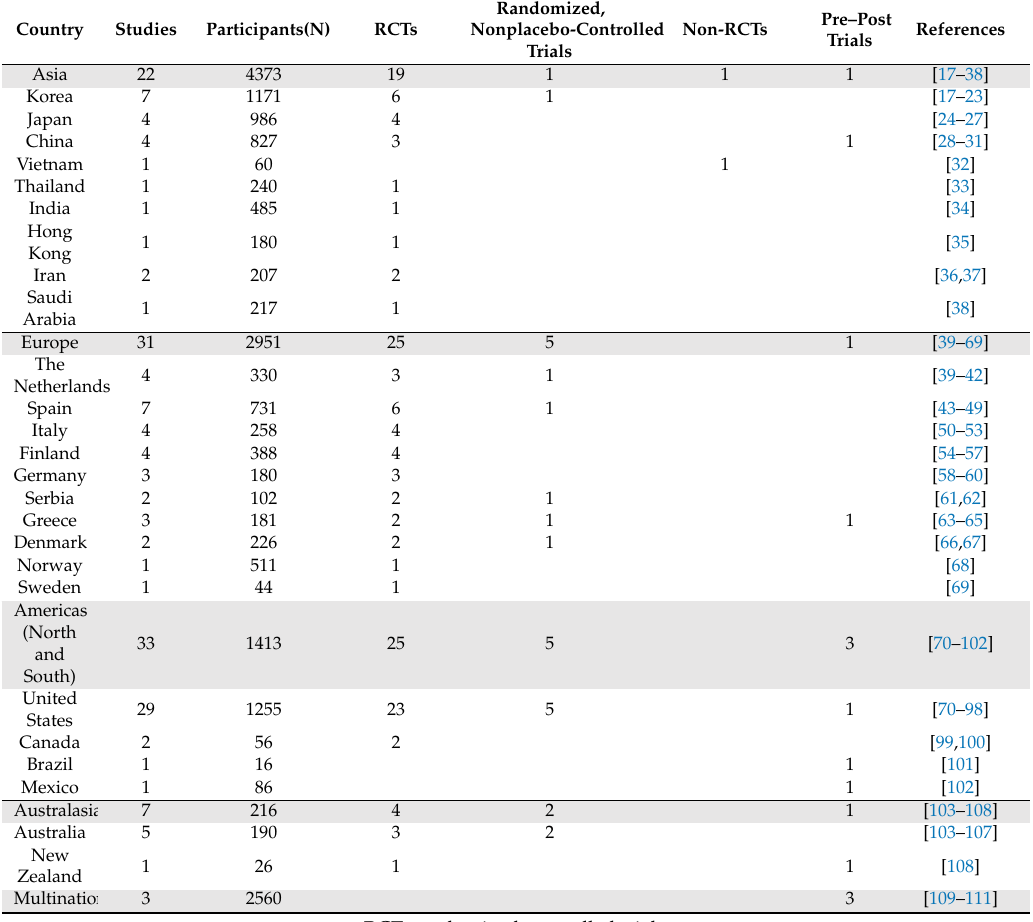
Table 1. Distribution of studies according to geographical